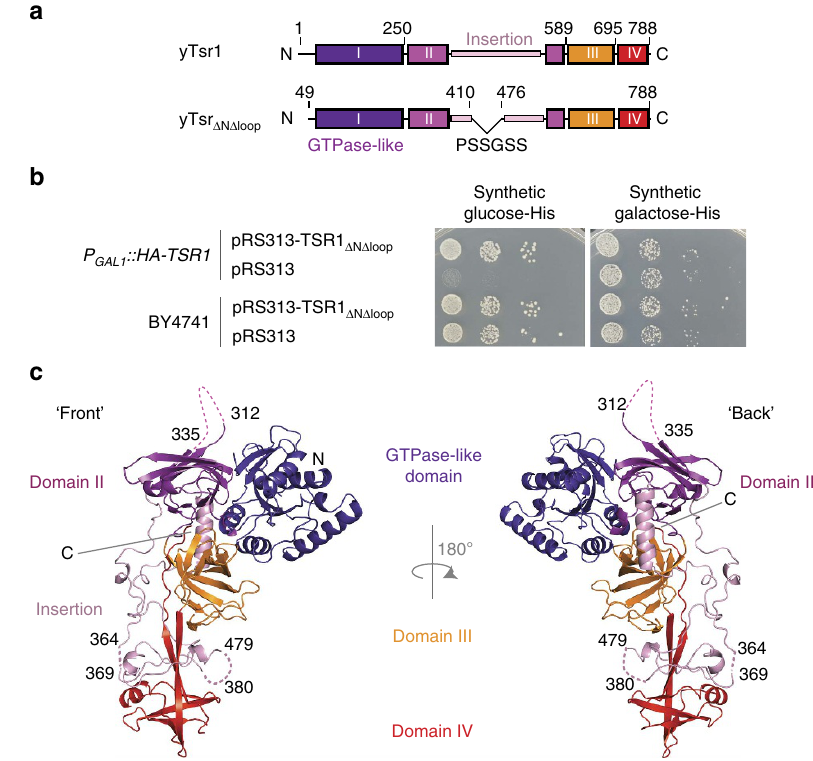
Figure 1 | Tsr1 is a multi-domain structure. ( a ) Schematic overview of Tsr1 domains, comparing the full-length protein with the Tsr1 D N D loop deletion mutant used in crystallization. ( b ) TSR1 (BY4741) and pGAL::HA-TSR1 strains were transformed with plasmid pRS313 expressing the Tsr1 D N D loop deletion mutant or the empty vector. Following growth in galactose medium, serial dilutions of the cultures were plated on galactose medium or on medium containing glucose to repress chromosomal expression of HA-Tsr1. ( c ) Overview of the structure defining front and back views, related by a 180 (cid:2) rotation. Domains are coloured according to the schema in a . Disordered regions are indicated with dotted lines and residue